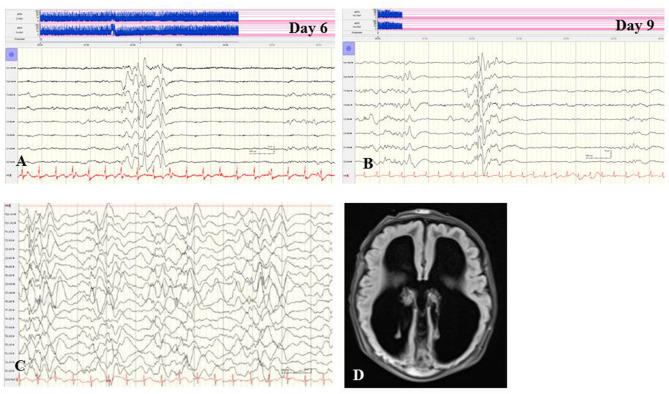
(A,B) EEG of a female term newborn with non-ketotic hyperglycinemia presenting apathy and hyperexcitability from day 1. First clinical seizures occurred at day 5. EEG at day 6 (A) and at day 9 (B) showed burst suppression with severe suppression (<4 μV) and intermittent high-voltage burst with diffuse spikes. (C,D) EEG and cMRI findings of a female neonate presenting myoclonic seizures, respiratory insufficiency, muscular hypotonia, hypoglycemia, and elevated CSF lactate and alanine levels. Interictal (C) and ictal EEG showed burst suppression during awake and asleep periods. (D) Brain MRI showed agenesis of corpus callosum and polymicrogyria. Heterozygous X-linked frameshift deletion in PDHα1 gene (skewed-X-chromosome inactivation) was detected. (Calibration is given in the figure, low-pass 30 Hz, high-pass 0.5 Hz).